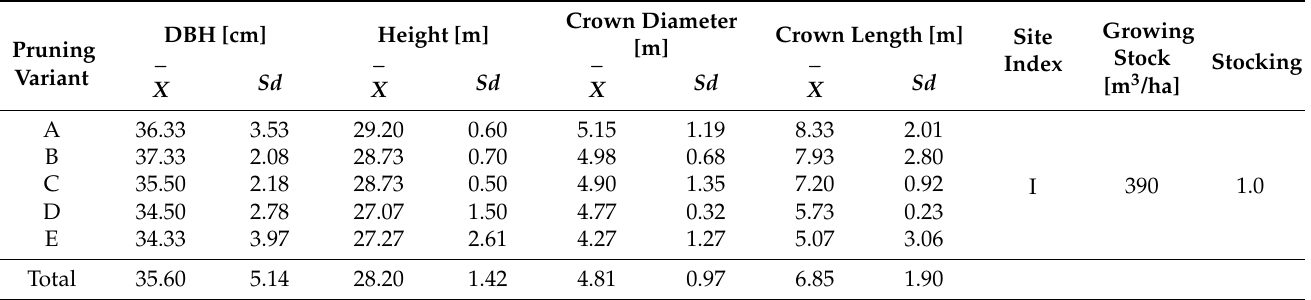
Table 1. Summary of stand structure in the five pruning variants in an eighty-three-year-old Pinus sylvestris stand.